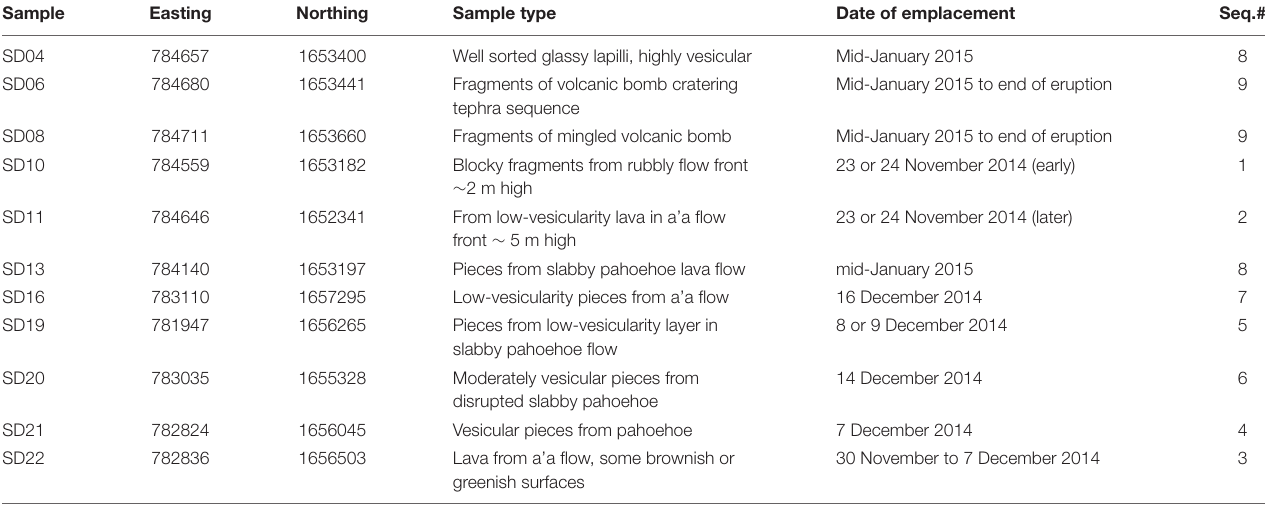
TABLE 1 | List of investigated samples, their localities and their order in eruptive sequence. Sample Easting Northing Sample type Date of emplacement